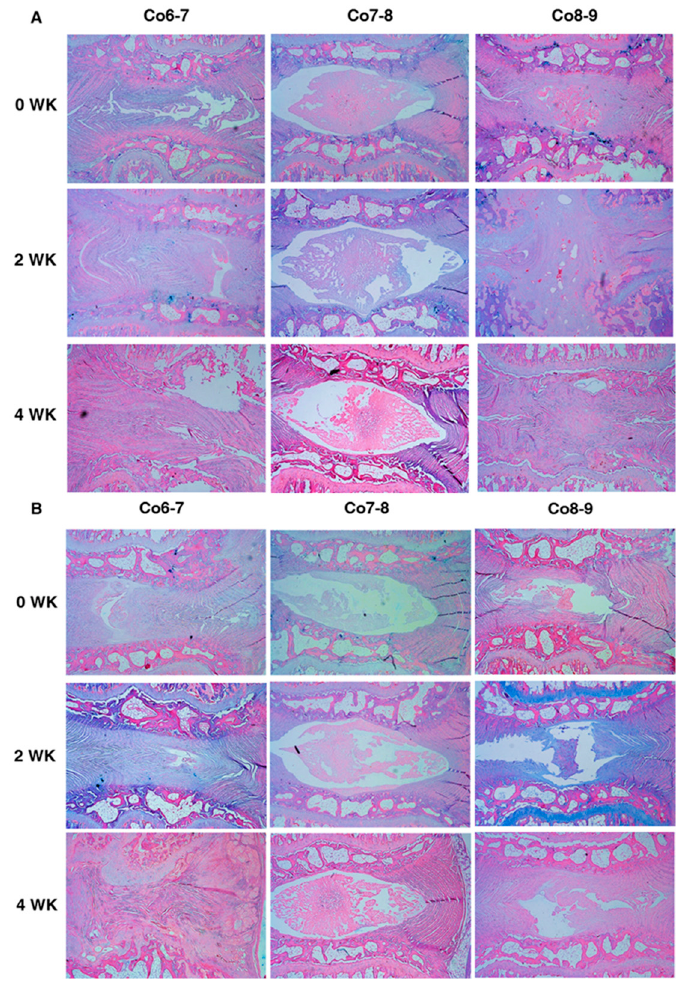
Figure 4. Alcian blue stain for comparing the proteoglycan change of injecting (original magnification: 40×). ( A ) Baculo-BMP-7-BMDMSCs and ( B ) BMDMSCs only at different treatment time-points (zero, two, and four weeks after puncture). Co7-8 is the control disc with no injection. Co6-7 and Co8-9 are the punctured discs with injection of cells.